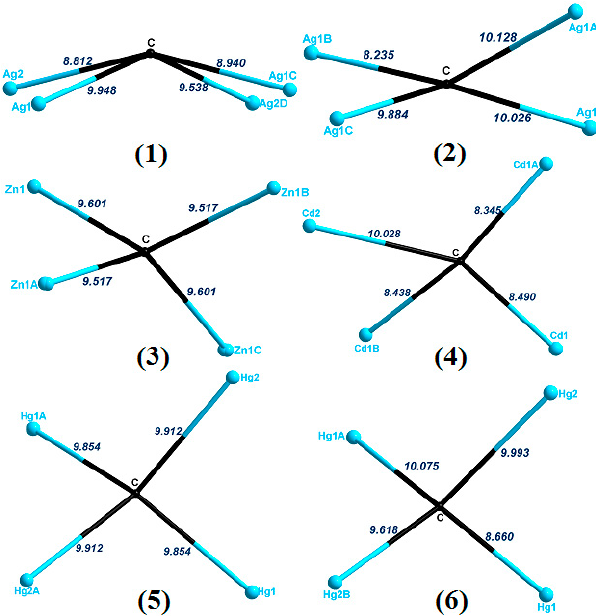
Figure 8. The simplified L connected the metal ions in complexes 1 – 6 .